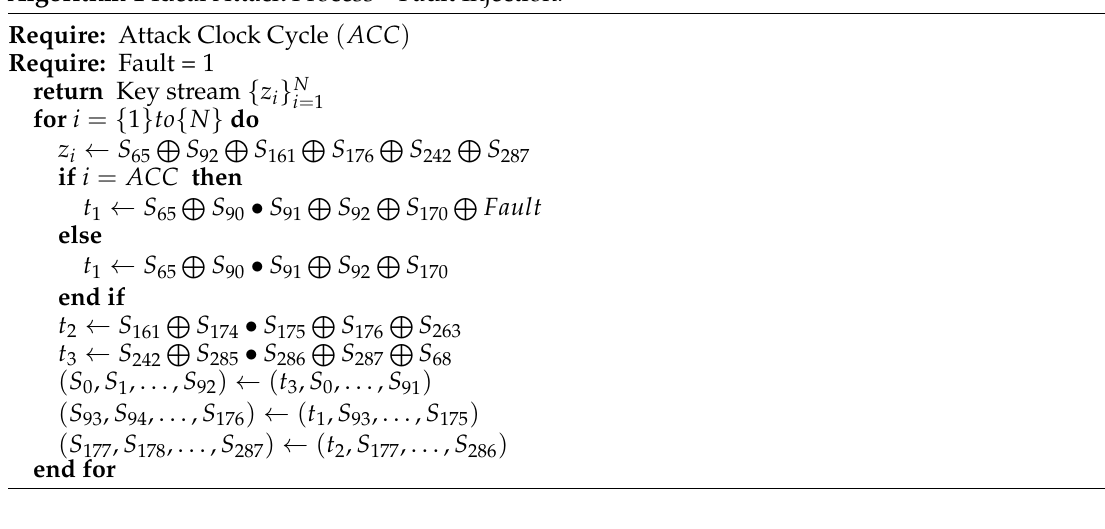
Algorithm 1 Ideal Attack Process—Fault Injection.